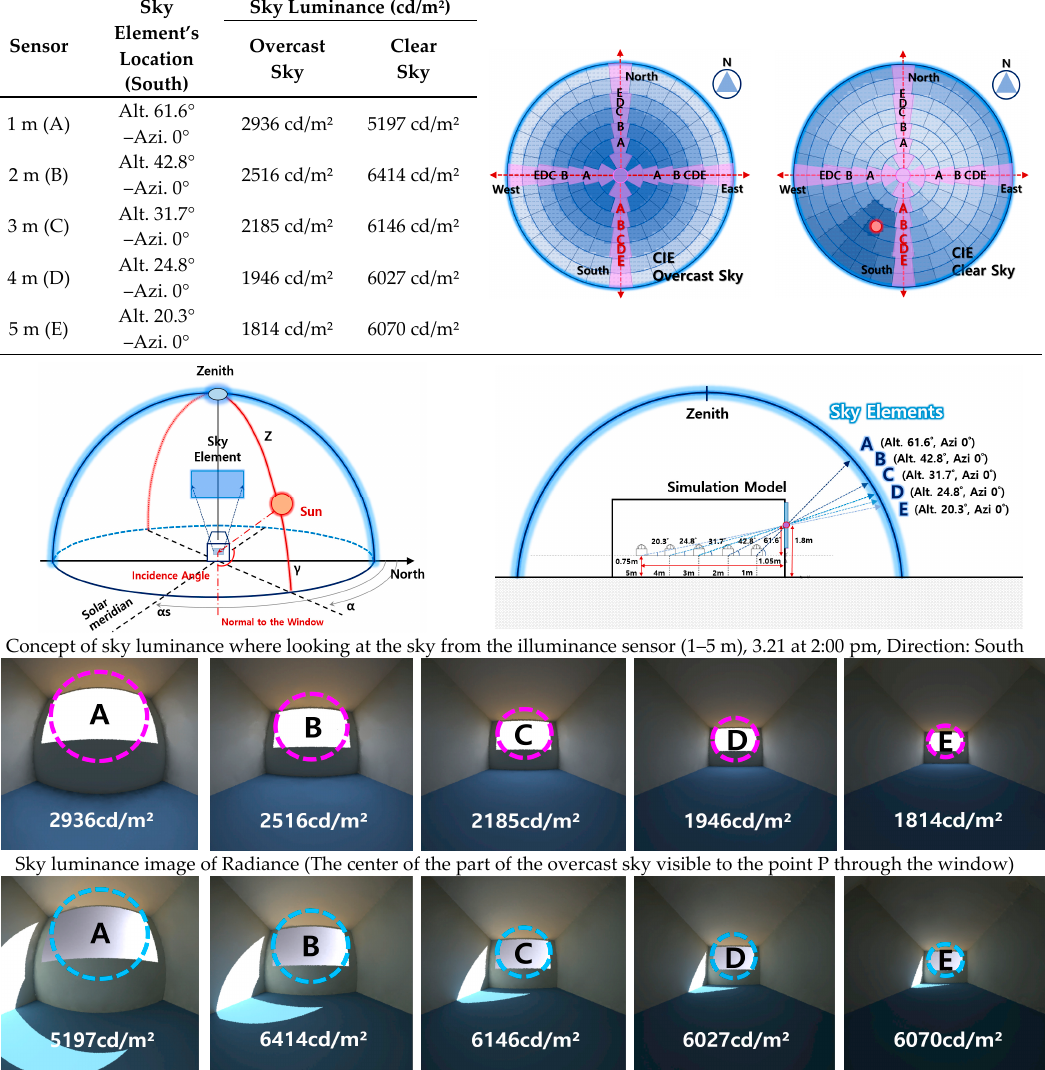
Energies 2019 , 12 , x